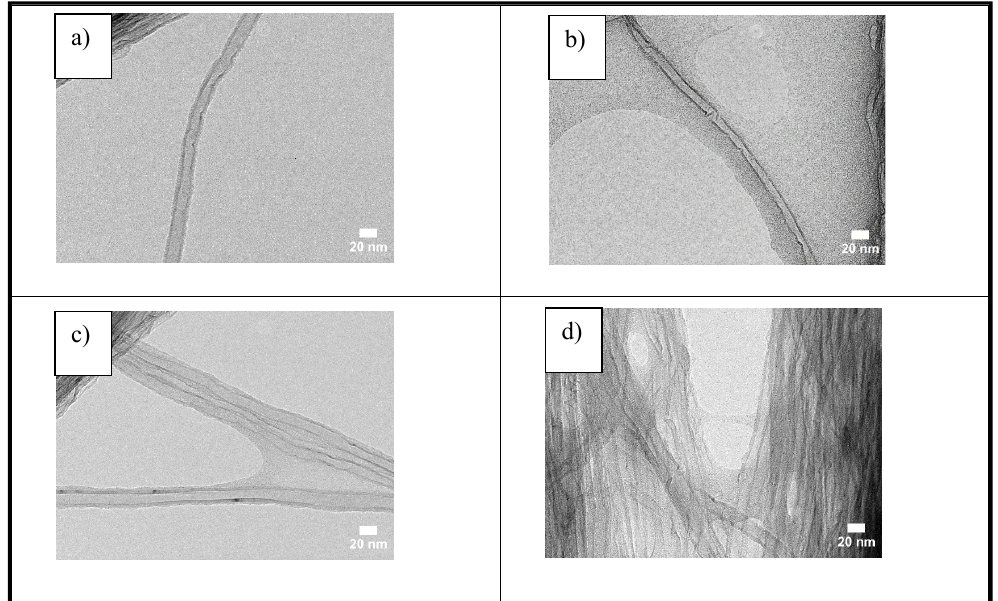
Figure 6. Transmission electron microscopy (TEM) images of carbon nanotube (CNT) and polymer-CNT composites. ( a ) Single-layer CNT web densified with NMP, ( b ) single-layer CNT web composited with PMMA, ( c ) single-layer CNT web composited with TPU, and ( d ) single-layer CNT web composited with Ultem TM .